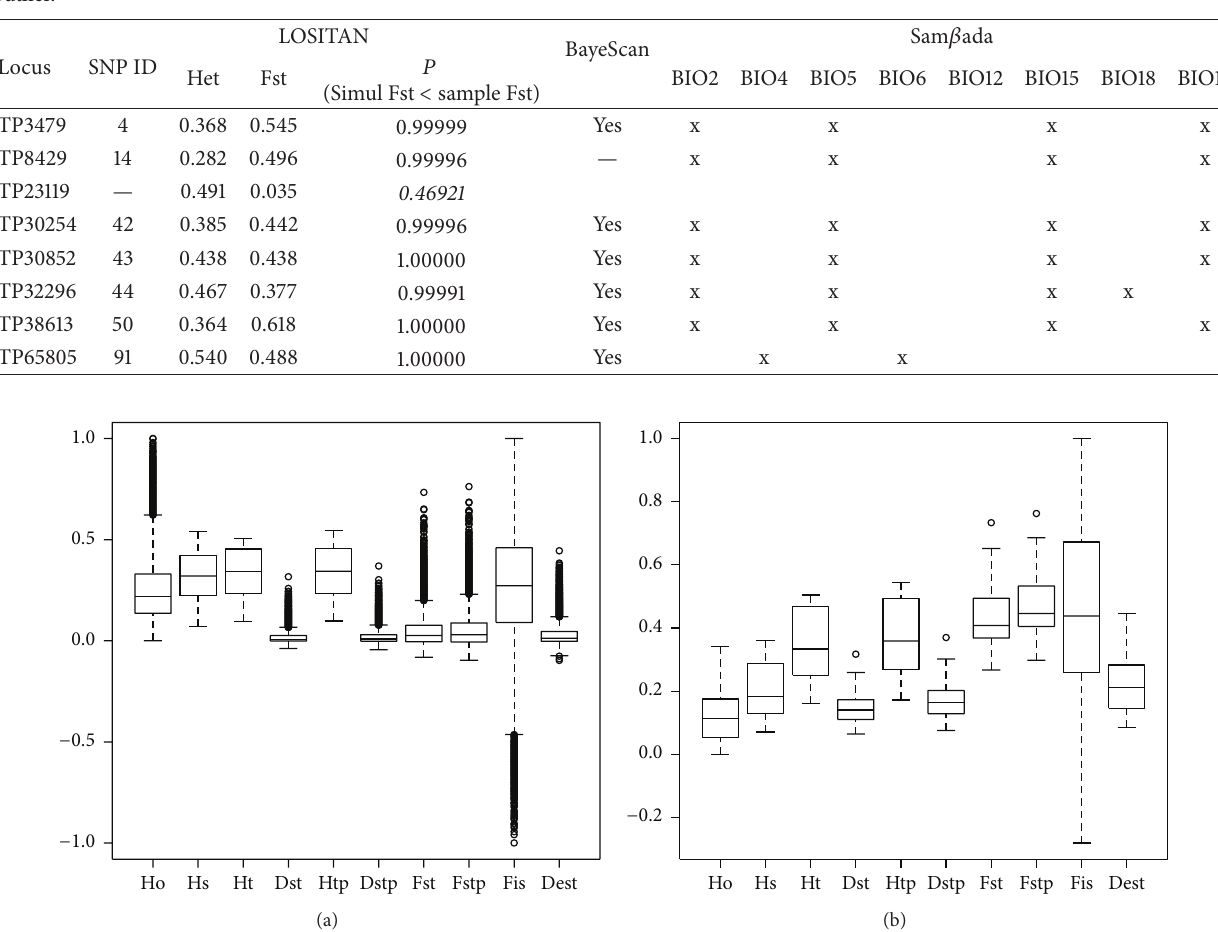
Figure 2: Summary statistics of genetic variation existing in Nothofagus dombeyi in Chile estimated by 10,109 neutral SNP (a) or 124 adaptive SNP (b). Ho: heterozygosity within population; Hs: genetic diversity within population; Ht: overall gene diversity; Http: corrected Ht; Dst: gene diversity among samples; Dstp: corrected Dst; Fst: fixation index; Fstp: corrected Fst; Fis: inbreeding coefficient per overall loci; Dest: measure of population differentiation.